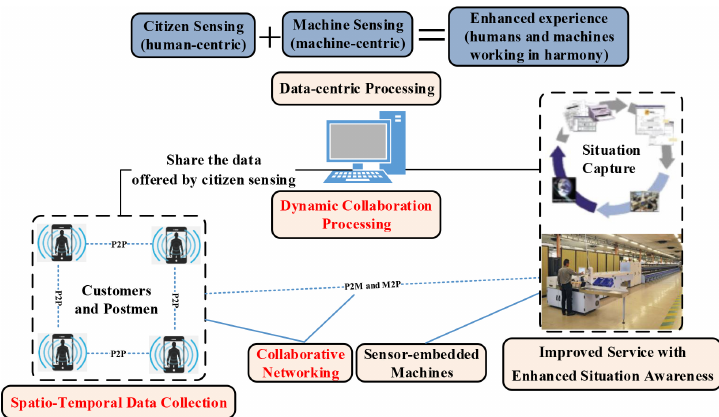
Figure 6. An example of networking two different data sources to improve the quality of service (a use case from La Poste). Integrating the spatio-temporal data from citizen sensing with the data from machine sensing provides enhanced experience and situational awareness. Such integration forms more complete information than either forms of sensing can provide alone. Additionally, it enables collaborative networking among different wireless